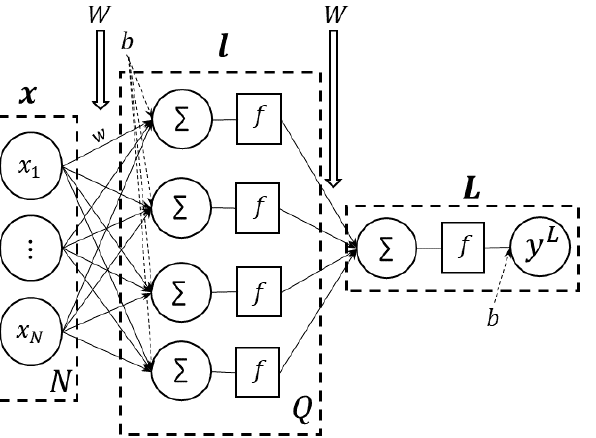
Figure 3. MLP architecture where x represents the input layer, l represents the hidden layer, L represents the output layer, b represents the bias and w represents the weights, adapted from